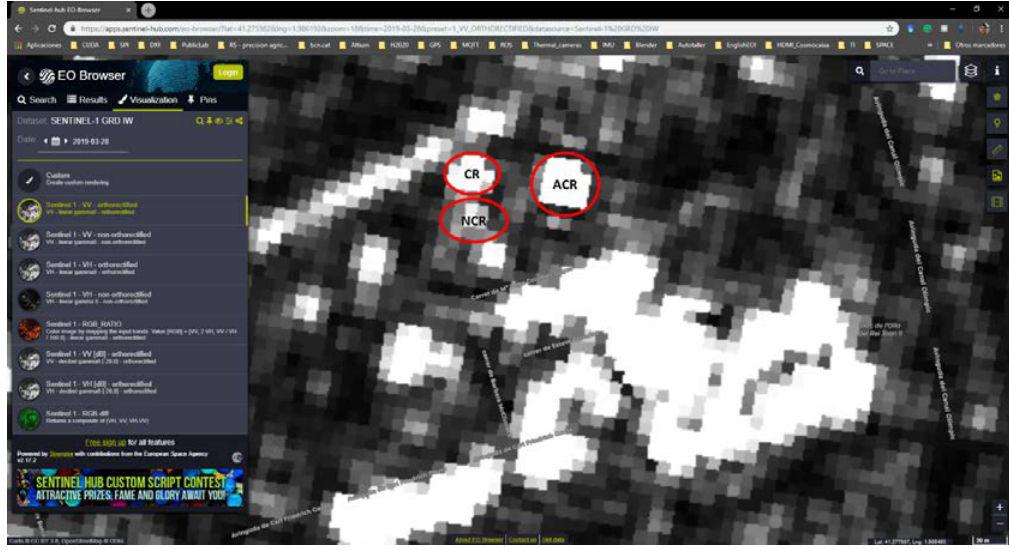
Figure 5. Amplitude Sentinel-1 image of the campus of CTTC. The red circles indicate the response of an AR (ACR), of a passive reflector (CR) and of a natural reflector (NCR)